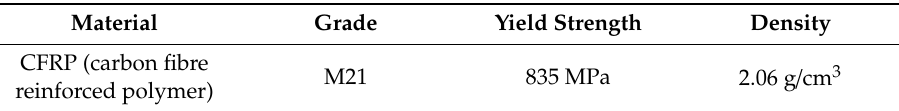
Table 2. Properties of the material